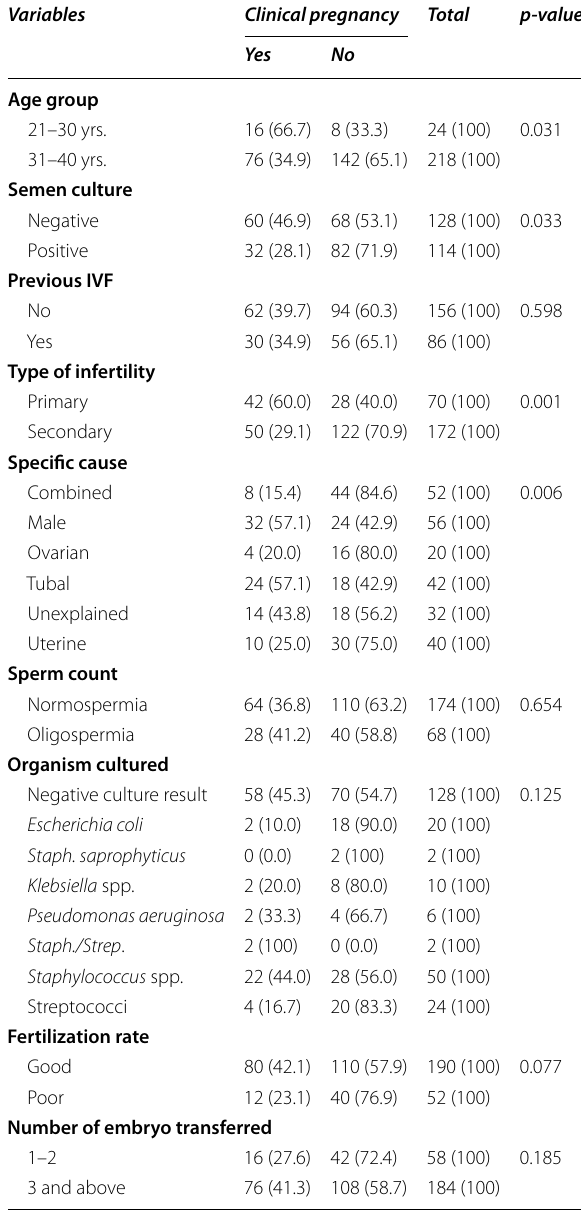
Table 4 Relationship of variables with clinical